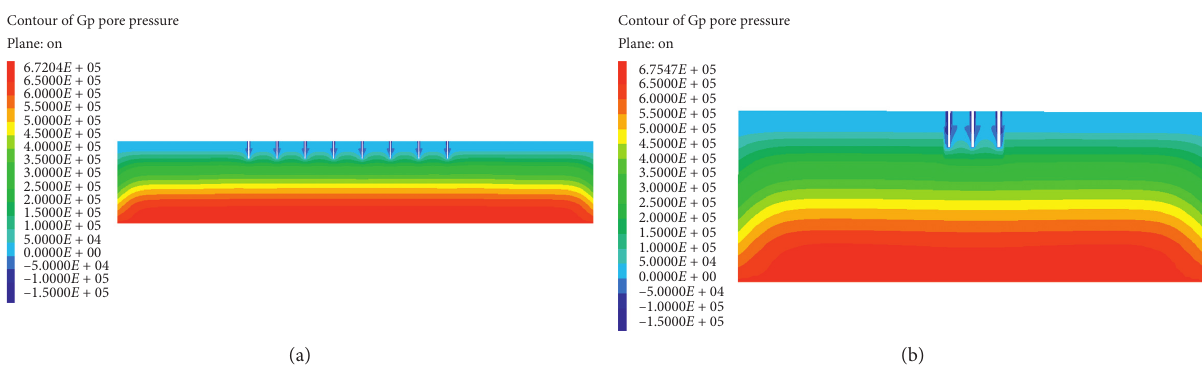
Figure 26: Group wells pore water pressure nephogram after the first drawdown (unit: Pa). (a) Cross section of the well midpoint. (b) Longitudinal section of the well